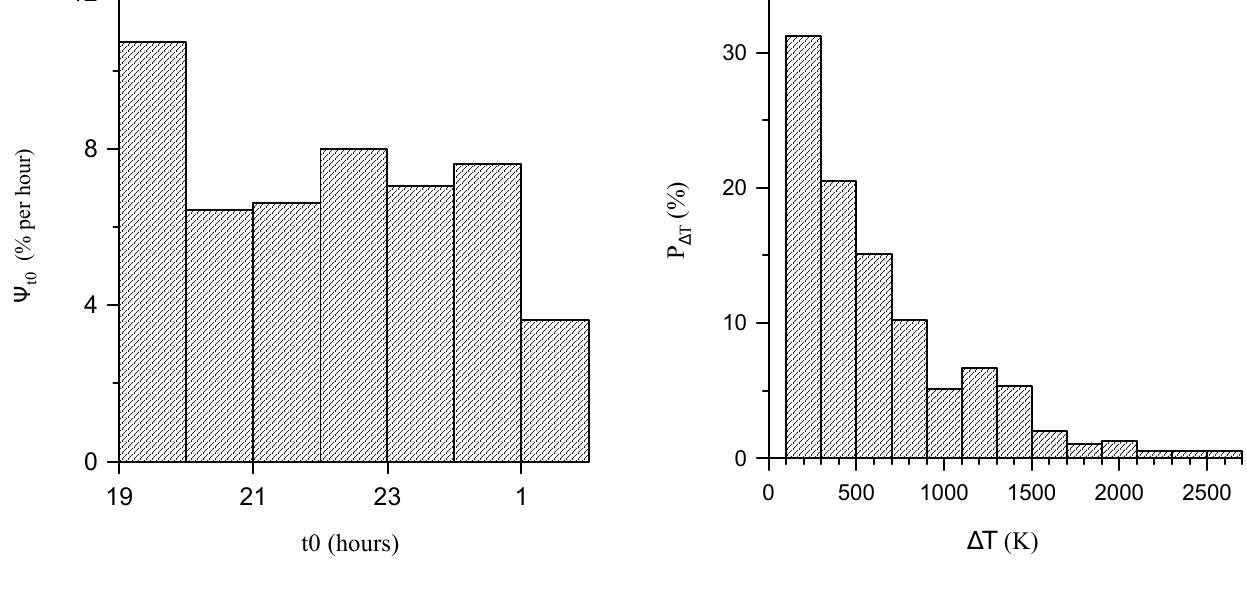
Fig. 5. The dependence of the NETE occurrence probability 9 t 0 for NETEs to begin during 1-hour time periods.